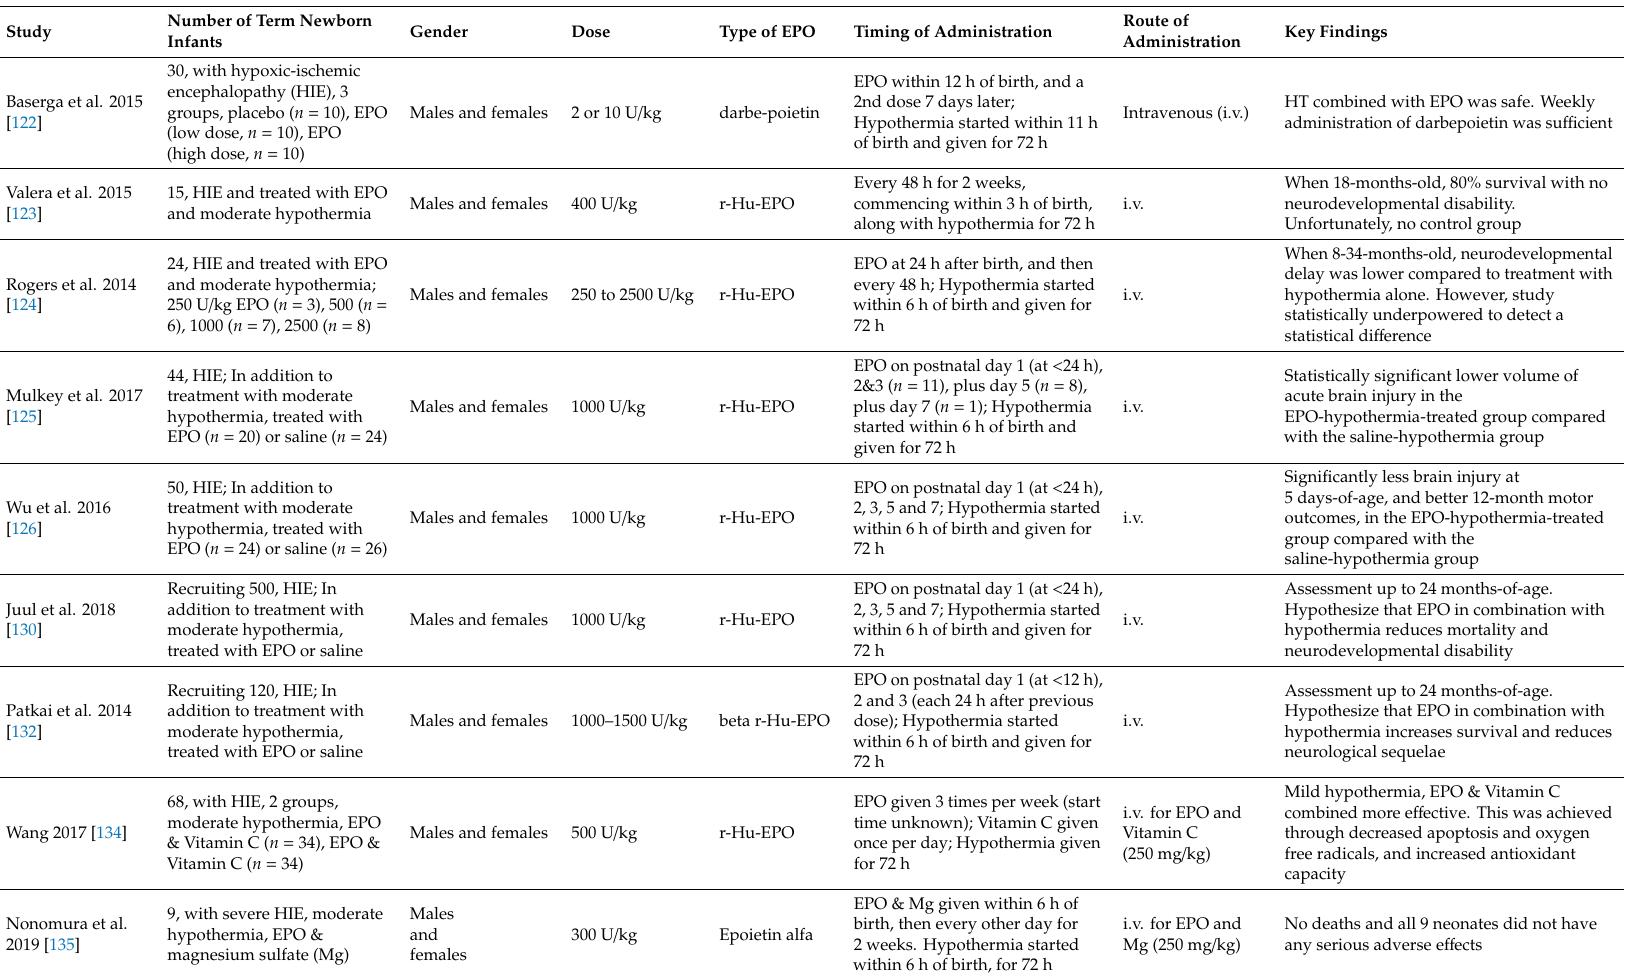
Table 4. Clinical studies on neonatal hypoxic-ischemic encephalopathy: E ff ect of EPO combined with moderate